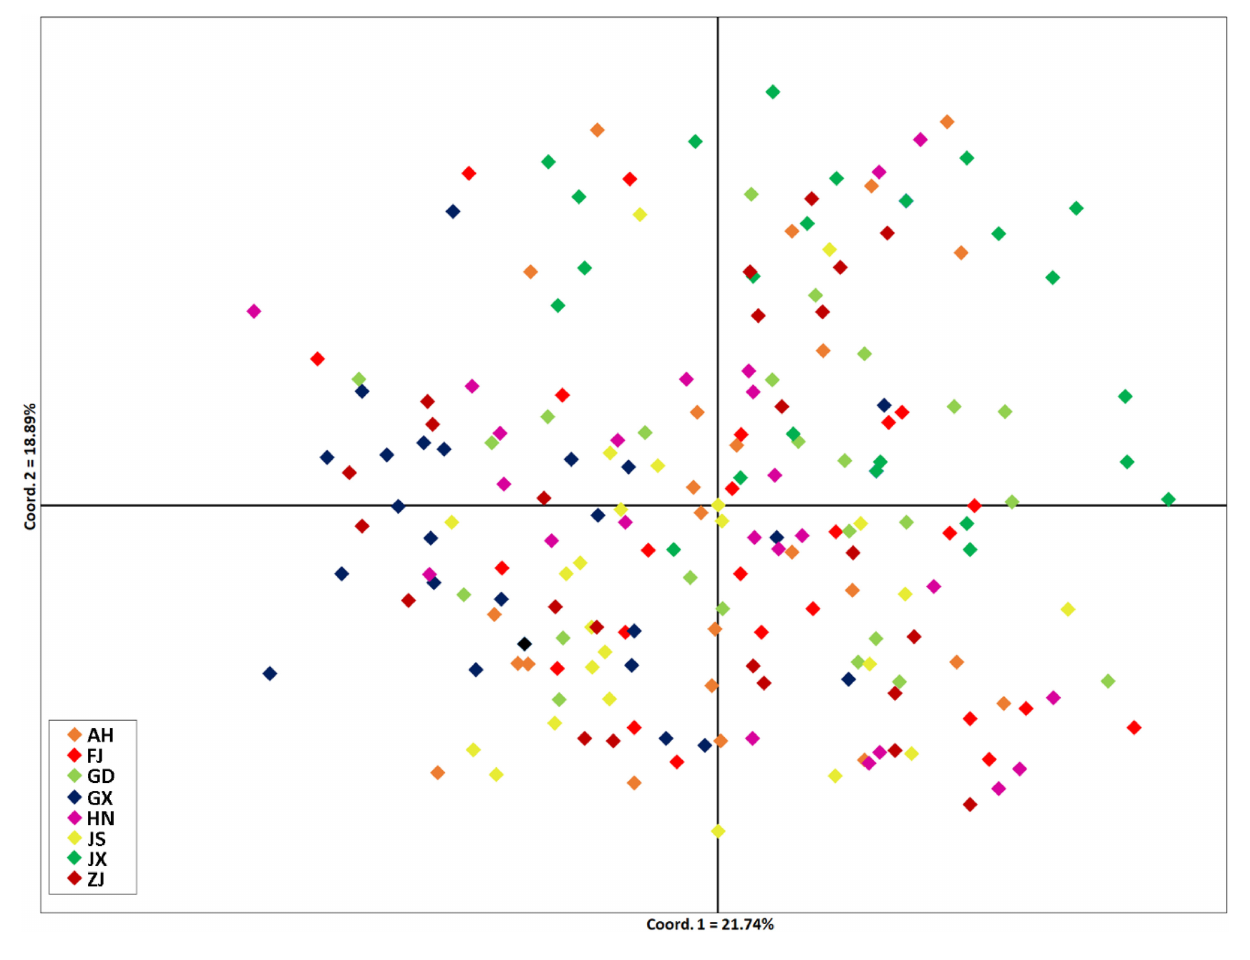
FIGURE 2 | PCoA based on pairwise Nei’s genetic distance estimates for the populations.